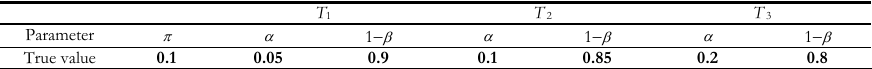
Simulations estimates setting for illness incidence and specificity and sensitivity of three tests T 1